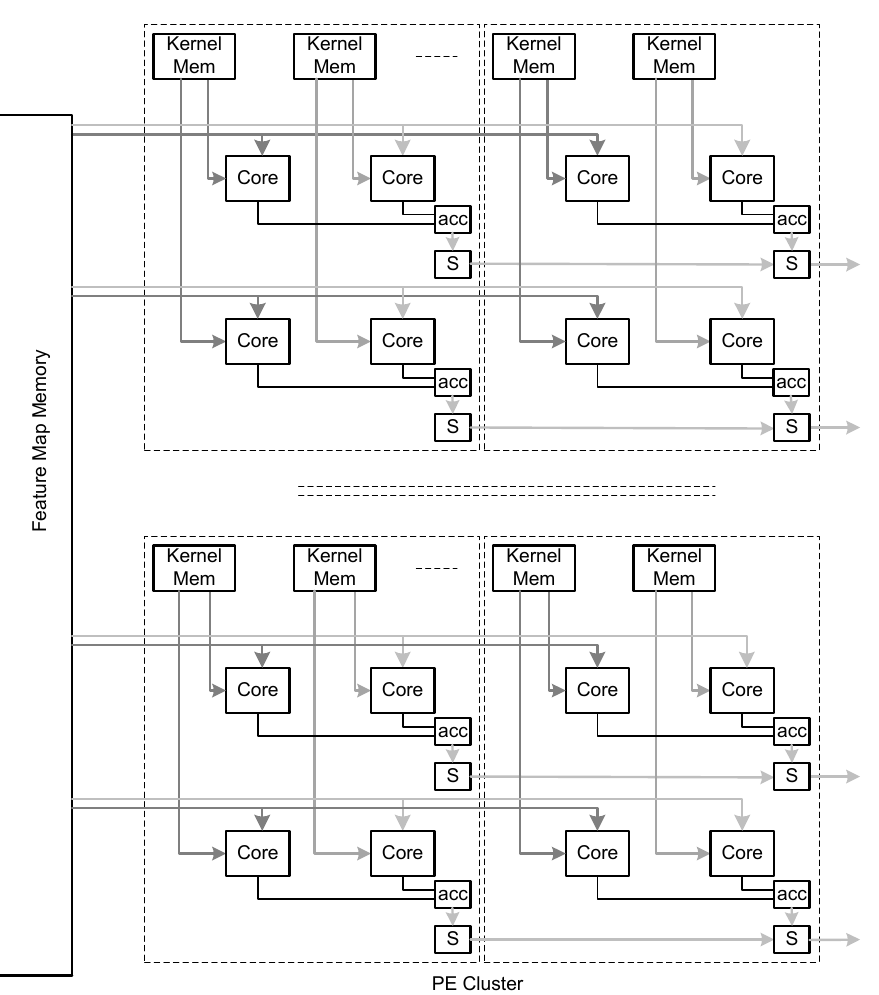
Figure 5. Architecture of the PE cluster with support for